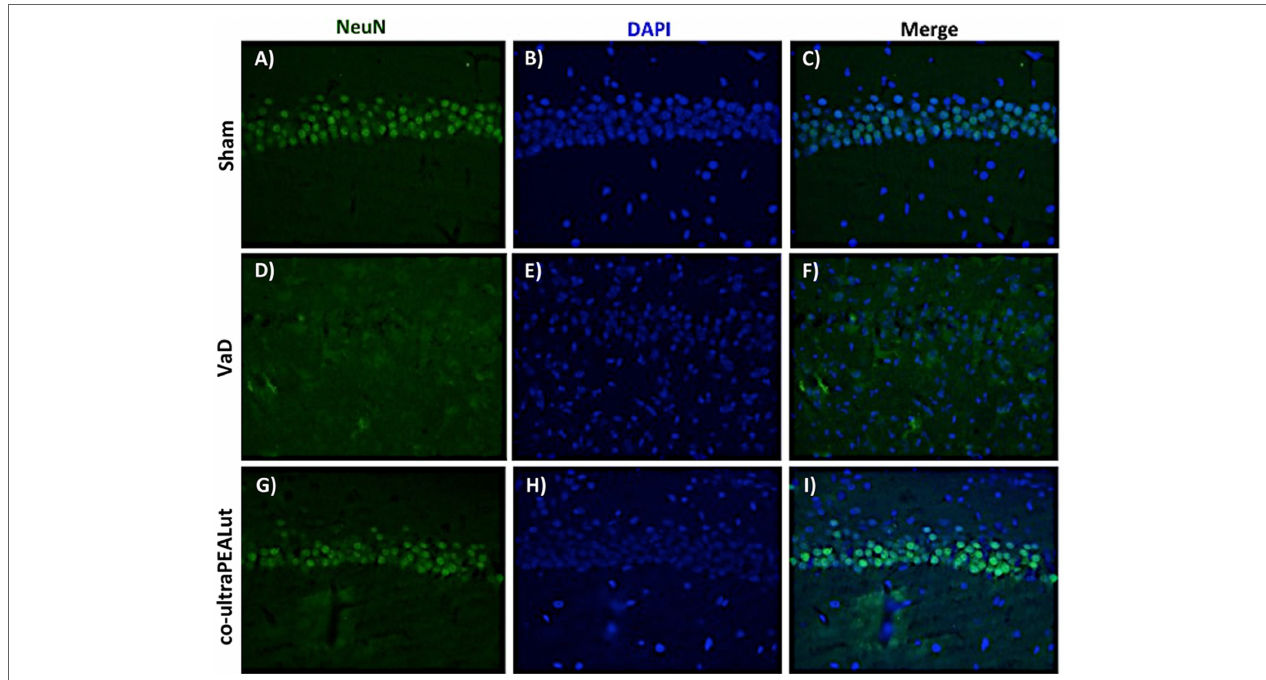
FigUre 8 | effects of co-ultraPealut on neuronal cells after carotid arteries occlusion . Results are shown for Sham group (a–c) , mice after carotid arteries ligation (D–F) , mice treated with co-ultraPEALut (g–i) . Representative images showing the intensity of fluorescent signals in regions labeled for NeuN and DAPI in the hippocampus from Sham animals (a,B) , animals submitted to carotid arteries occlusion (D,e) , and animals treated with co-ultraPEALut (g,h) . The co-localization between NeuN/DAPI is represented by the images (c,F,i) . Immunofluorescence staining showed that carotid arteries ligation decreased the NeuN immunocontent 15 days after surgery, while treatment with co-ultraPEALut restored the number of neuronal